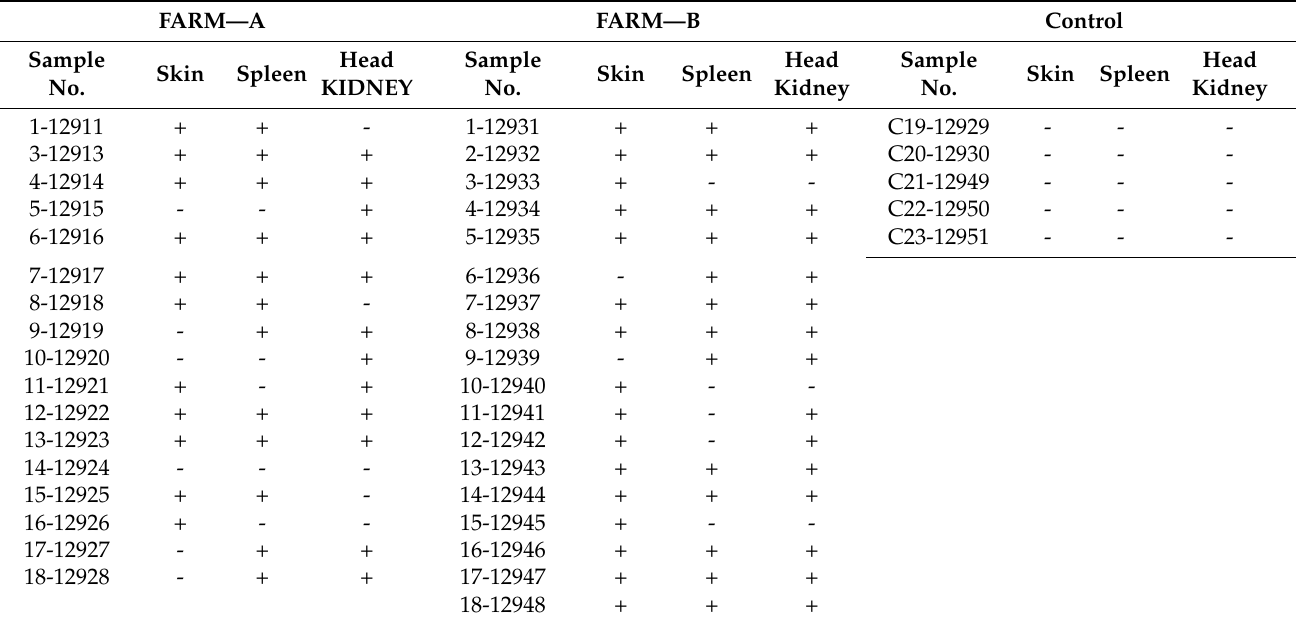
Table 2. Results of the PCR assay performed according to Galeotti et al., 2017 [24] on the skin spleen and head kidney tissues from symptomatic and control trout using the RiFCfw–RiFCrev primers on the Amplicon obtained by RLO1–RLO2 primers with the first-step